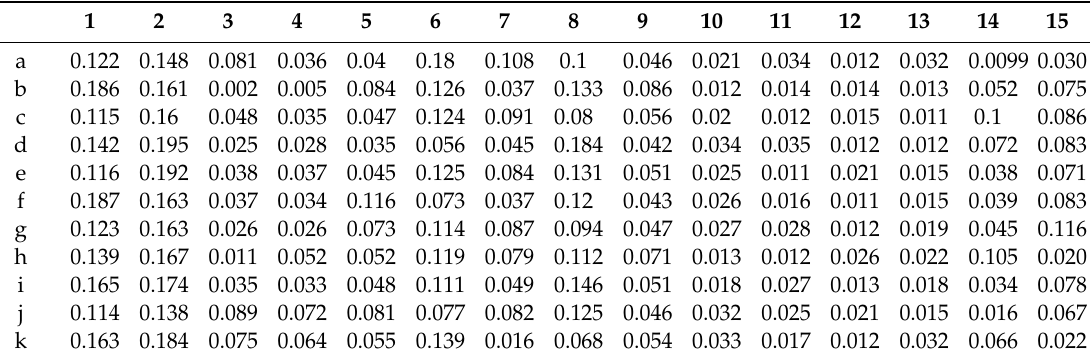
Table 6. The weights of indicators in each of the UA evaluation